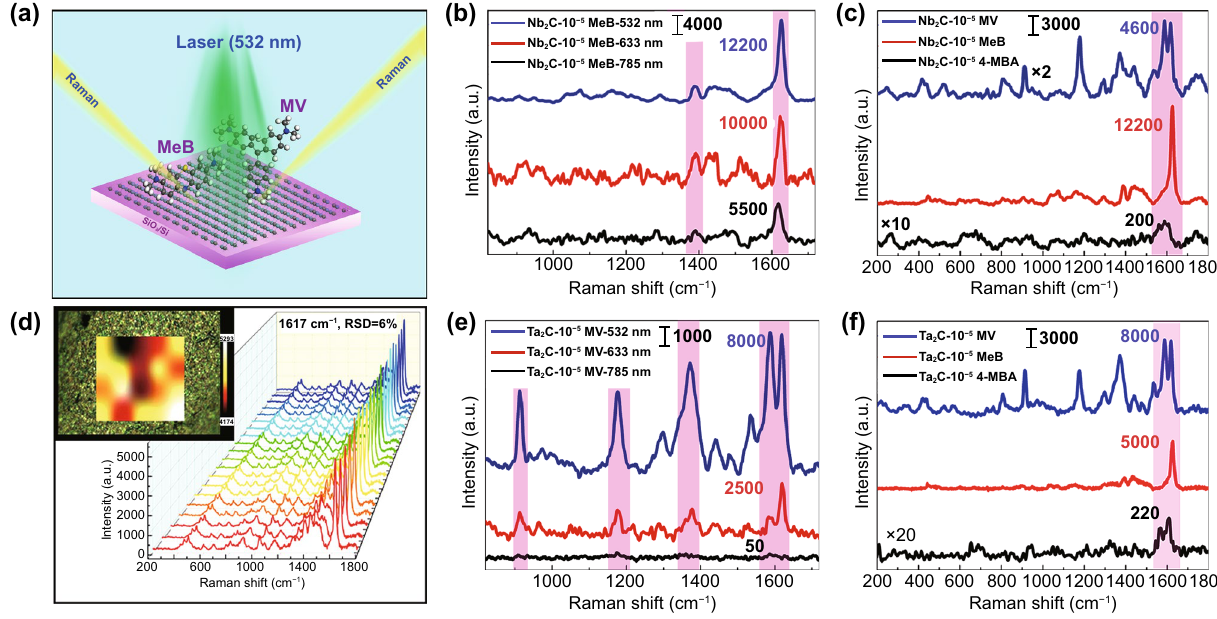
Fig. 4 a Raman schematic diagram of the Nb 2 C/Ta 2 C NSs as the substrates for the Raman scattering of MeB and MV molecule under the excitation laser of 532 nm. b , e Raman spectra of 10 −5 M MeB on Nb 2 C NSs substrates ( b ) and 10 −5 M MV on Ta 2 C NSs substrates ( e ) under the different wavelength laser excitation of 532 nm, 633 nm, and 785 nm. c, f Raman spectra of 10 −5 M 4-MBA, MeB, MV on Nb 2 C NSs ( c ) and Ta 2 C NSs ( f ) substrates under the excitation laser of 532 nm. d The Raman signals of 10 −5 M MeB collected from 20 selected points on the Nb 2 C NSs substrates and the corresponding Raman mapping image at 1617 cm −1 with the area of 40 × 50 μm 2 (the step size is 10